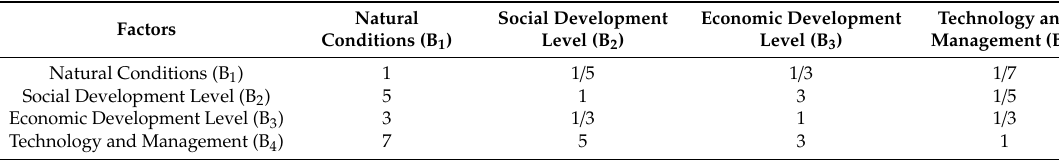
Table 4. Judgment matrix of first expert on criterion layer.